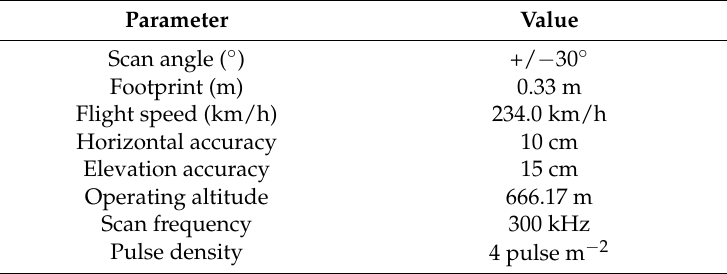
Table 3. Airborne lidar system